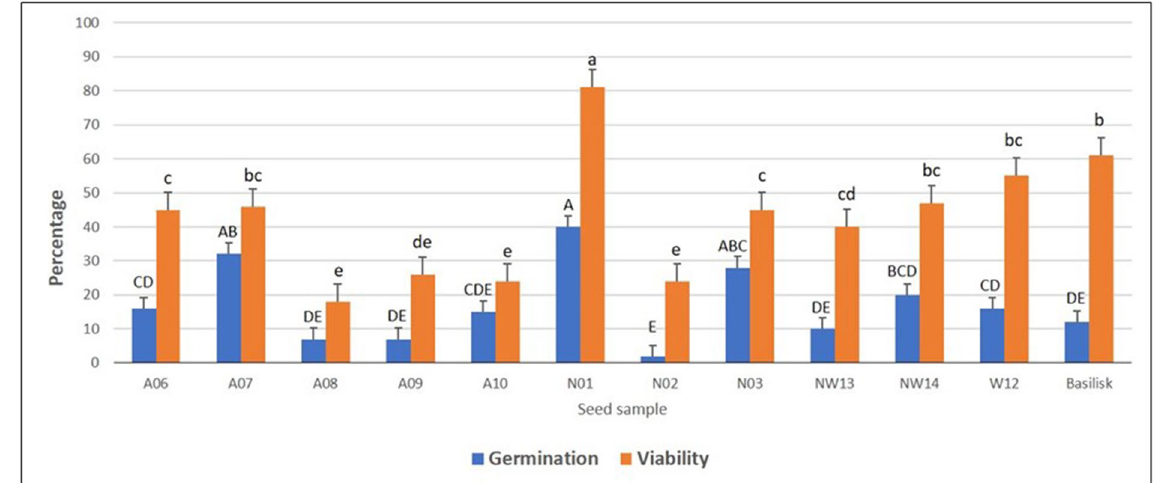
Figure 4. Germination and viability percentage for 12 Urochloa spp. seeds samples from Cameroon and seeds of Urochloa decumbens cv. Basilisk from Brazil. Bars of same colour with different letters are significantly different ( P < 0.0001). The error bars are standard errors (SE).